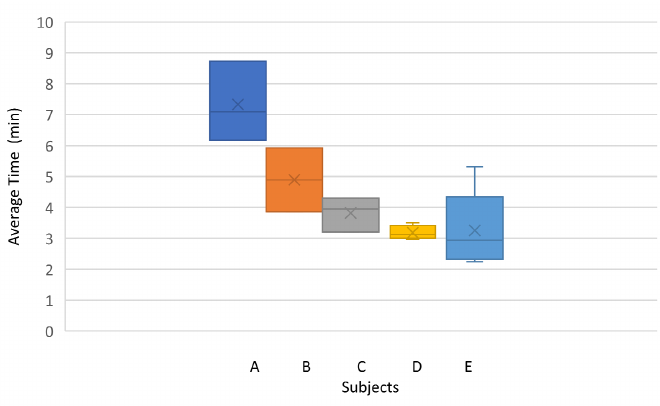
Figure 16. Average total time to complete task per subject.